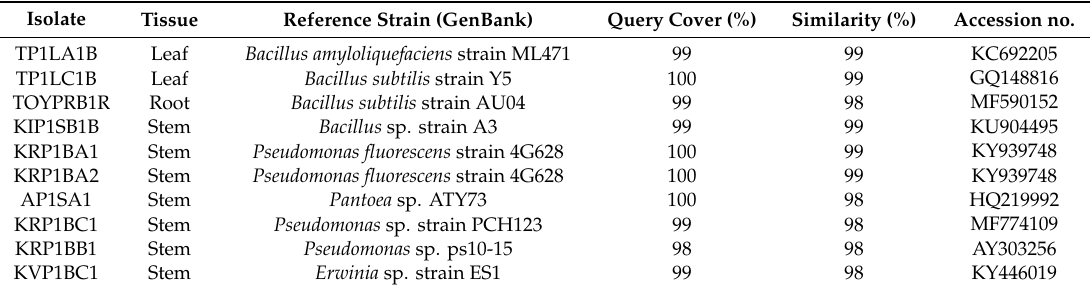
Table 3. Identity of endophytic bacteria from leaf, stem and root tissue based on 16S rRNA sequencing. Isolate